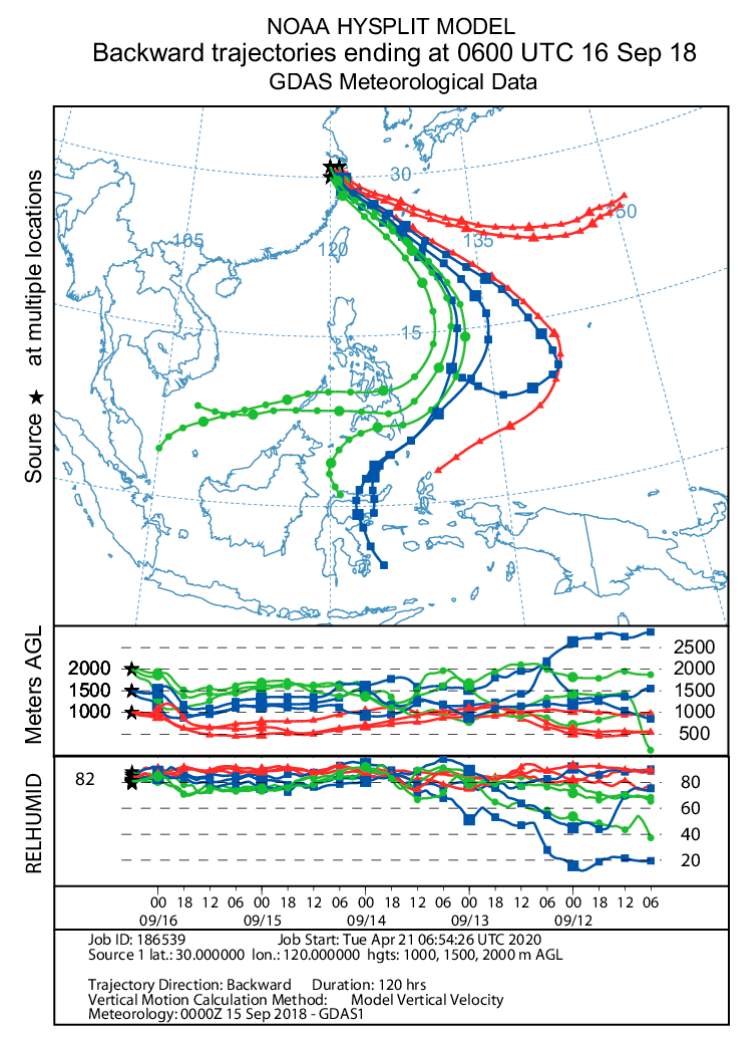
Figure 10. The 120-h backward trajectories of above ground level (m) and relative humidity (%) for air parcels located at (120°E, 30°N), (120°E, 31°N), and (121°E, 31°N) at 0600 UTC 16 September 2018 at the above ground level of 1000 m (red lines), 1500 m (blue lines), and 2000 m (green lines).